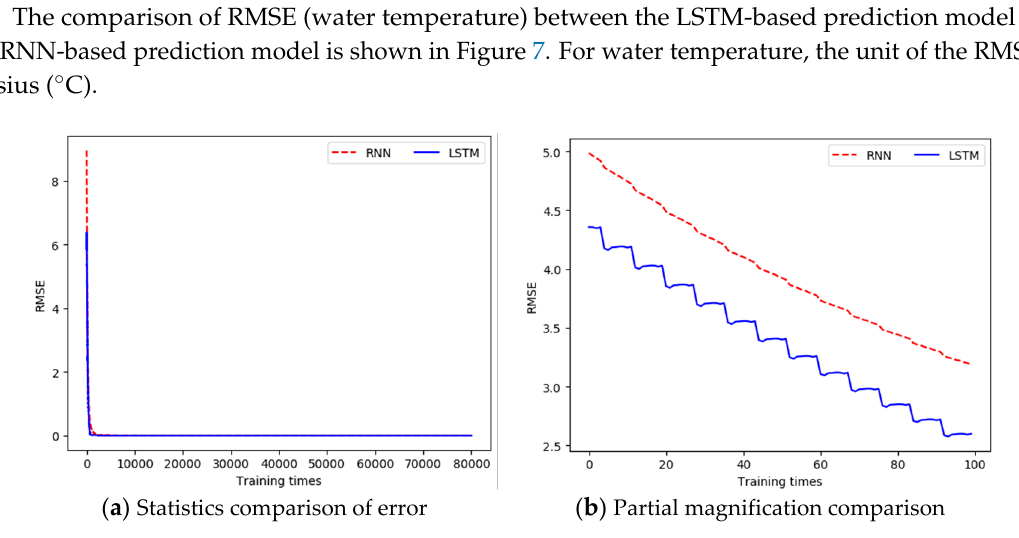
Figure 7. Comparison of the difference between the output value in each training and the real value when building the water temperature prediction